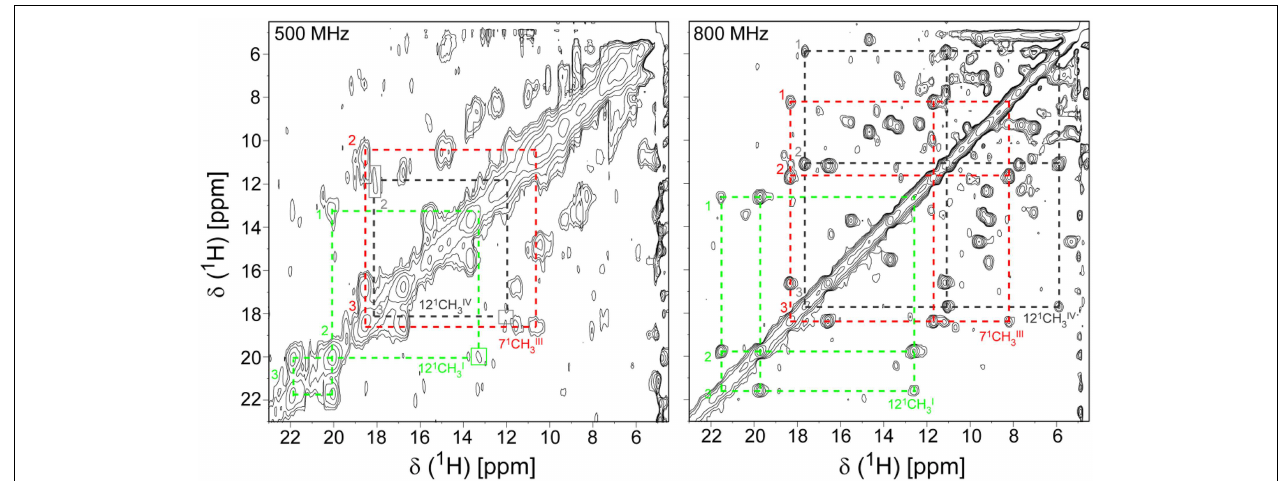
FIGURE 5 | Expansions of 2D EXSY NMR spectra of PpcA acquired at 500MHz (500mM ionic strength) and 800MHz (250mM ionic strength), at different levels of oxidation (288K and pH 6). Cross-peaks resulting from intermolecular electron transfer across the oxidation stages 1–3 are indicated by dashed lines for the hemes 12 1 CH I 3 (green), 7 1 CH III 3